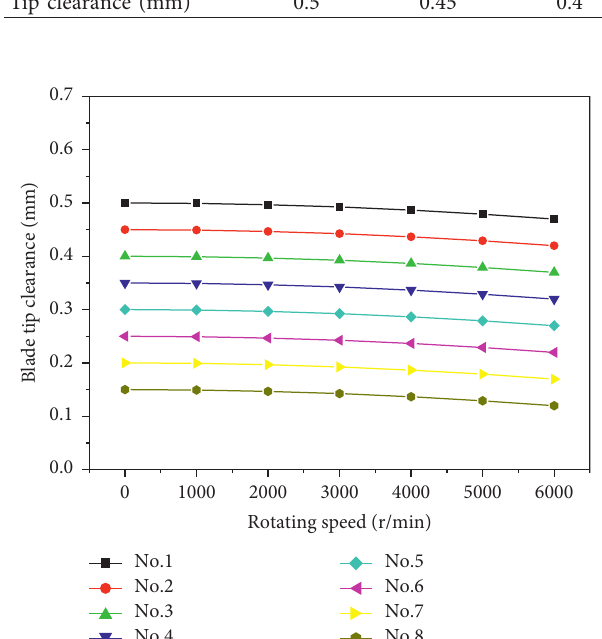
Figure 2: Tip clearance value of each blade at different rotating